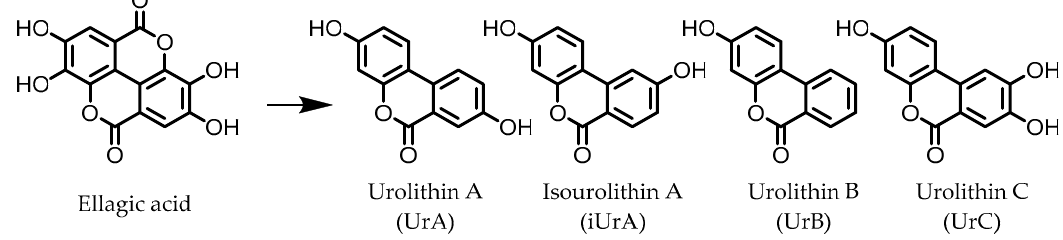
Figure 2. Structures of ellagic acid and several urolithins produced by the gut